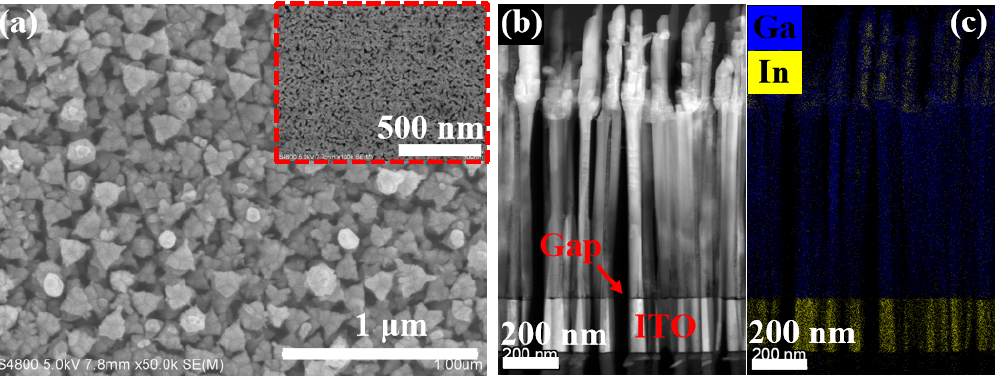
Figure 2. SEM/STEM characterizations of detached (In,Ga)N NWs. ( a ) Plan-view SEM image of the top of detached (In,Ga)N NWs. The inset is the plan-view SEM image of the bottom surface of detached GaN parasitic layer. ( b ) Side-view STEM image and ( c ) high-resolution EDX mapping of detached (In,Ga)N NWs.